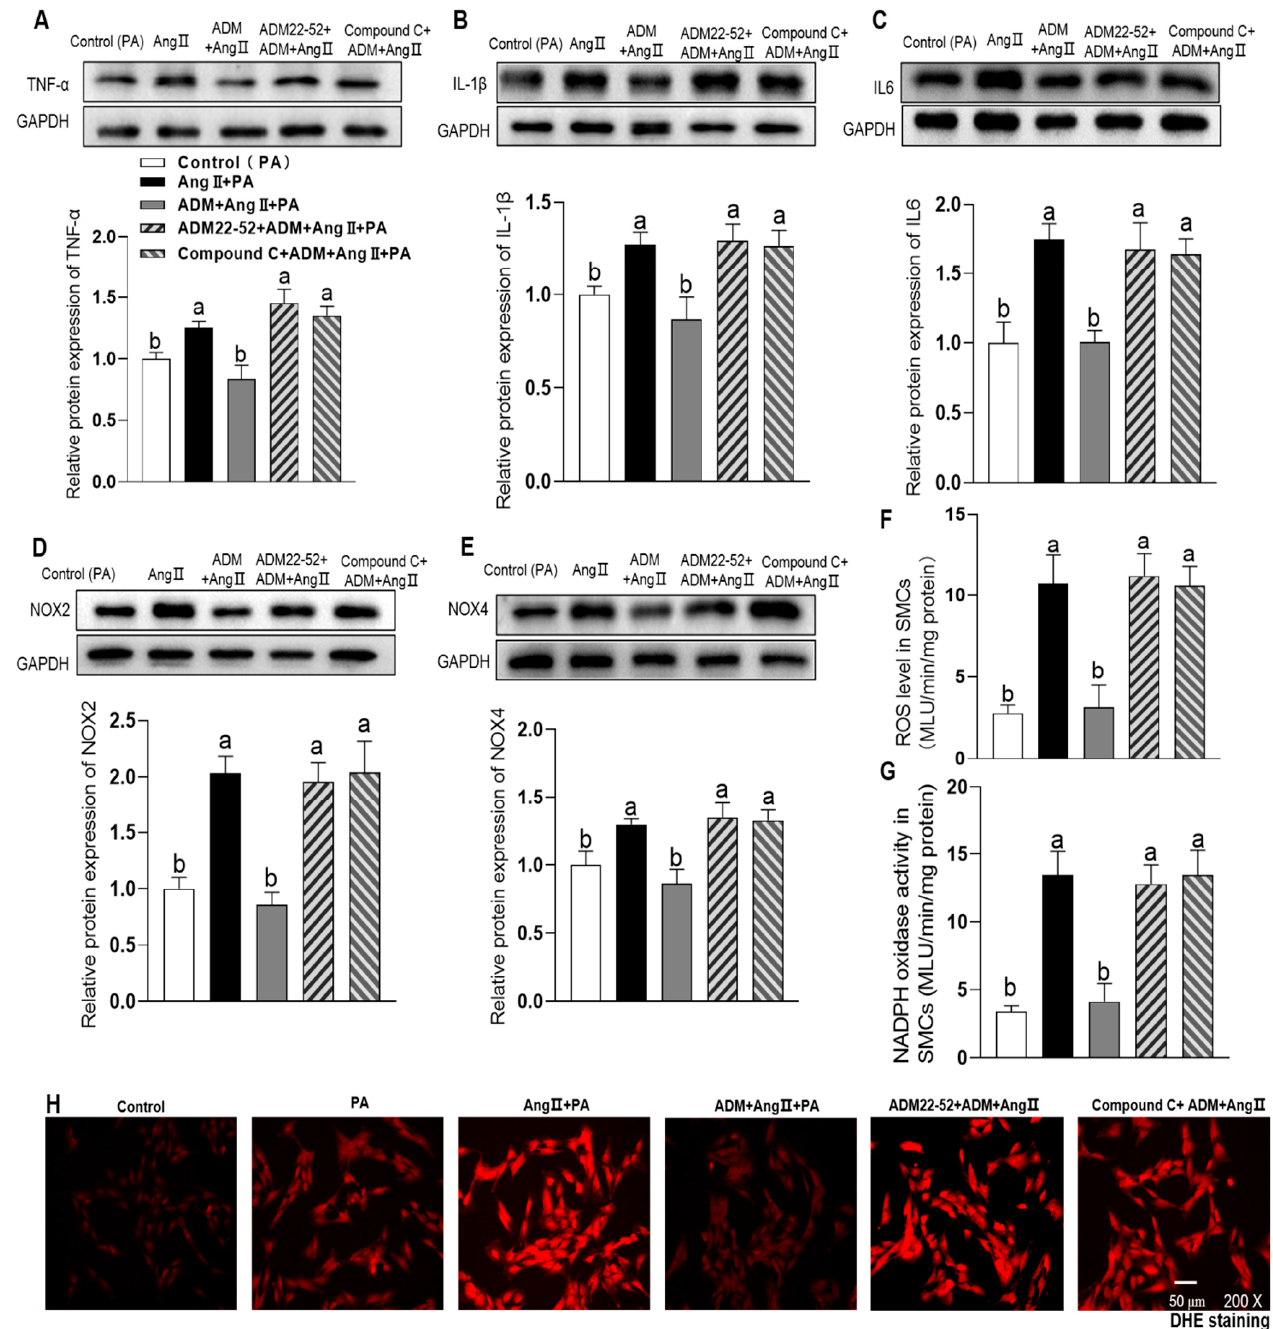
Figure 6. The roles of 1 μ M ADM22-52 or 10 μ M compound C in ADM’s response to the combination of PA plus Ang II-induced protein expressions of pro-inflammatory cytokines, including TNF α ( A ), IL-1 β ( B ), IL-6 ( C ) and oxidative stress, including the protein expression of NOX2 ( D ) and NOX4 ( E ), ROS level ( F ), NADPH oxidase activity ( G ) and intracellular ROS evaluation by DHE fluorescence staining ( H ) in A7r5 cells. ADM (10 nM) was administrated in A7r5 cells for 30 min, then cells were exposed to PA plus Ang II (10 nM) for further 24 h. ADM22-52 or compound C was added 30 min before ADM application. Each value indicates mean ± SEM. n = 3 to 6. Values with the same superscript letter are not significantly different and the different letters indicate significant differences between the groups ( p < 0.05, one-way ANOVA followed by Bonferroni post hoc analysis, ( A – G )).